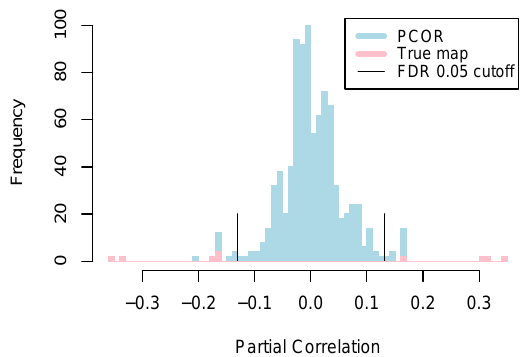
Figure 5: Distribution of all PCOR coe ffi cients are plotted in blue histograms and pink histograms, which correspond to no edge and true edges in the true network. FDR is used in GGMs to deter- mine PCOR coe ffi cients that are significantly di ff erent from zero. A FDR cuto ff of 5% confidence is marked in the histogram (black line). The PCOR coe ffi cient corresponding to true network edges (pink histogram) are not strictly distinguishable by such cut-o ff